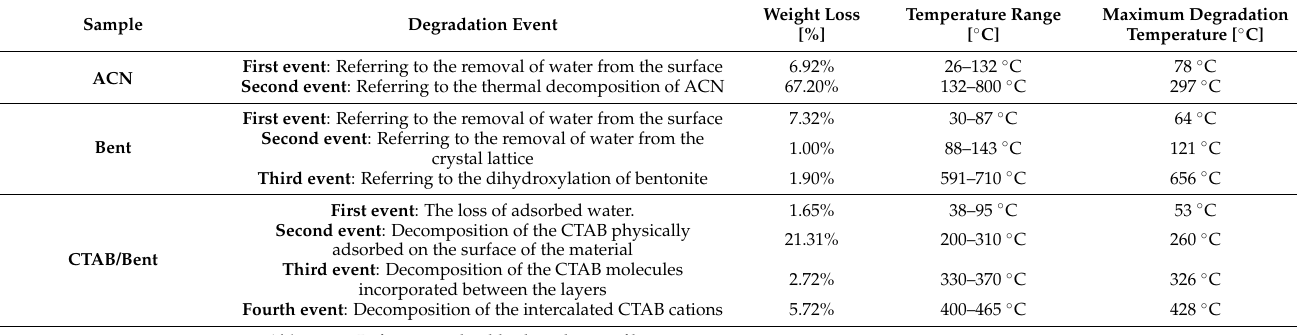
Figure 4. TG ( a ) and DTG ( b ) curves of ACN, Bent, CTAB/Bent, and dyed solids. Table 1. Main thermal degradation events of Bent and its derivatives.